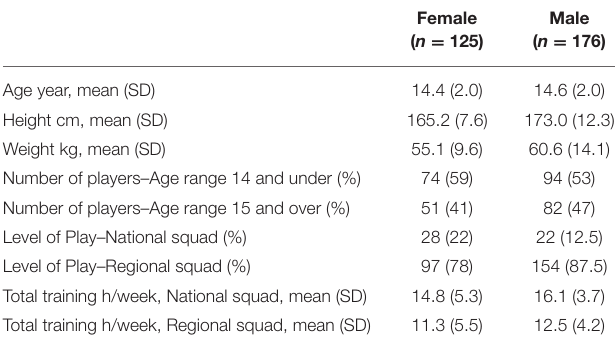
TABLE 1 | Characteristic data of the tennis players in the study ( n